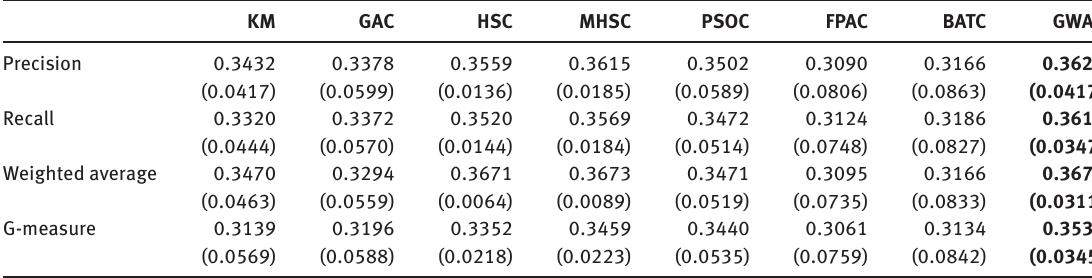
Table 10: Mean (SD) of Cluster Quality Matrices for CMC Data Set.